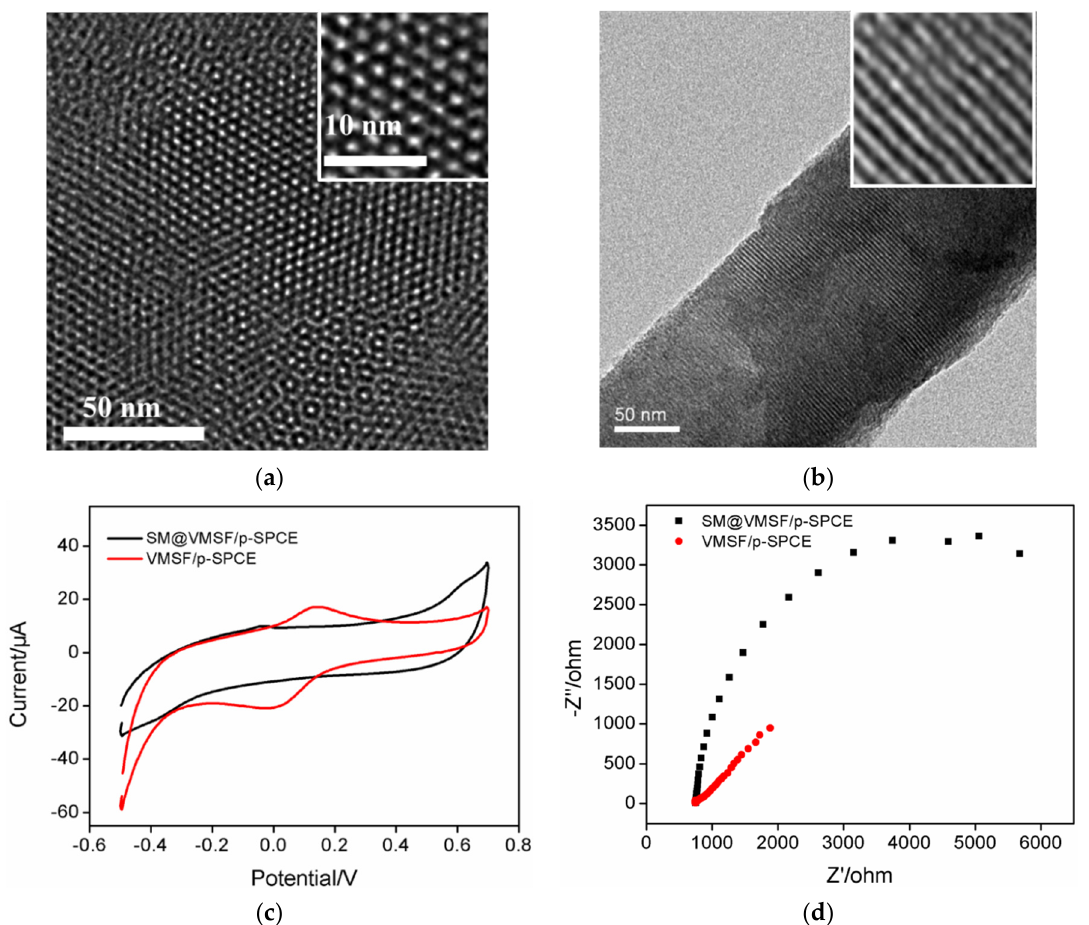
Figure 3. Top-view ( a ) and cross-sectional ( b ) TEM images of VMSF at different magnifications. ( c ) CV curves obtained at different electrodes in 0.05 M KHP solution containing 0.5 mM Fe(CN) 63+ . ( d ) Nyquist plots of different electrodes obtained in 0.1 M KCl solution containing 2.5 mM K 3 Fe(CN) 6 and 2.5 mM K 4 Fe(CN) 6 .